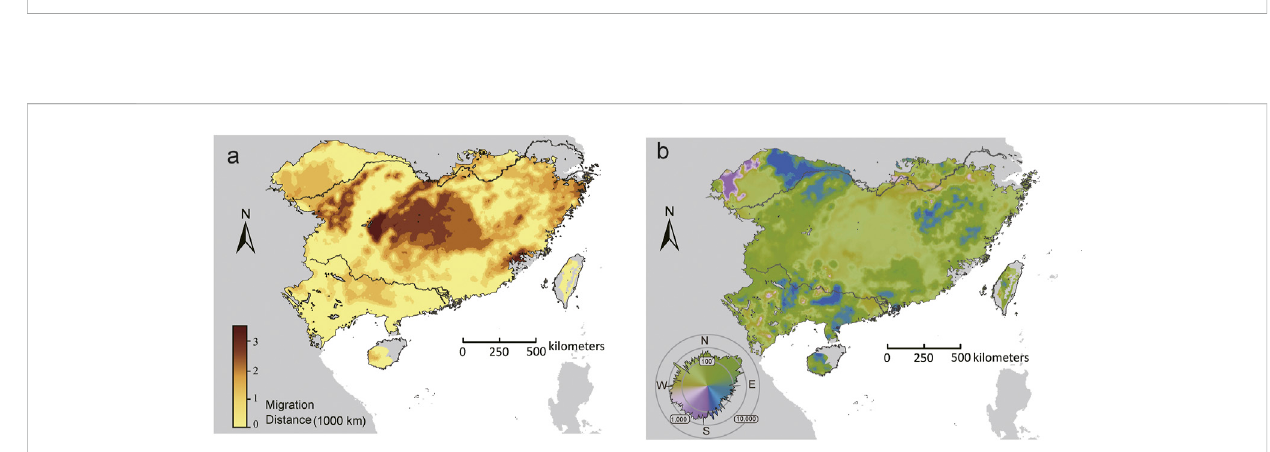
FIGURE 6 Theinitialbearing (A) andmigratedistance (B) tolocationsthatcanminimizeforwardoffsetinthefutureclimatescenarios(2070,SSP370).Thepolar histogram in (B) indicated the log 10 number of cells within each bearing